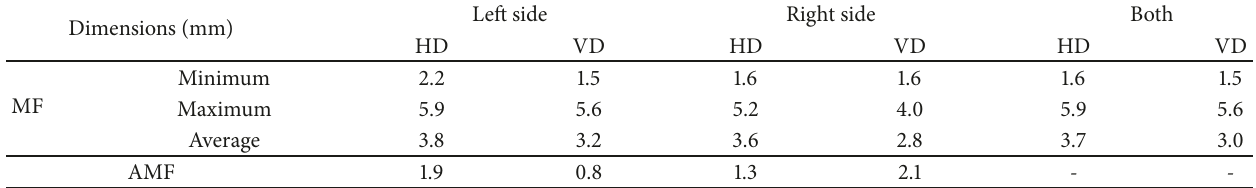
Table 2: Dimensions of the MF and AMF in Zambian adult human mandibles (n=33). Dimensions (mm)